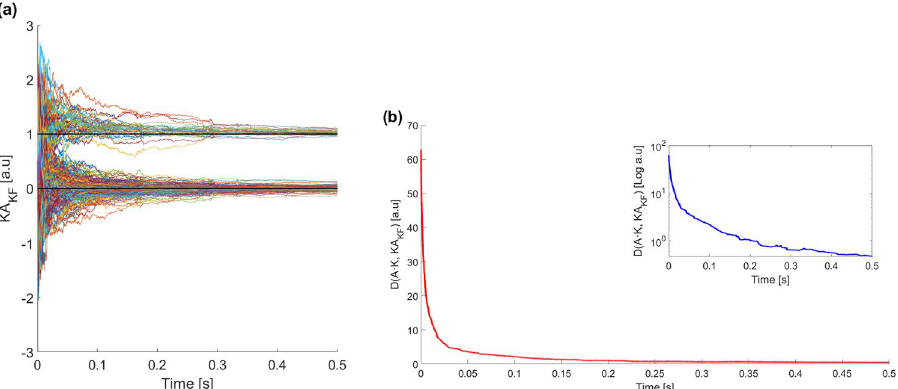
Figure 7. ( a ) Evolution of estimated parameters K ij ≡ K · A ij with K = 1 for the network of 28 coupled Rössler- like oscillators (see Table 1). The coupling strengths converge to either 0 or 1 representing not connection and connection, respectively, between nodes i and j . ( b ) The distance between the inferred adjacency matrix and the real one, D ( K , K UKF ) , converges to zero. In the inset of panel ( b ) we show the logarithmic evolution of the distance, D , showing that all the estimated coupling terms converge to the correct